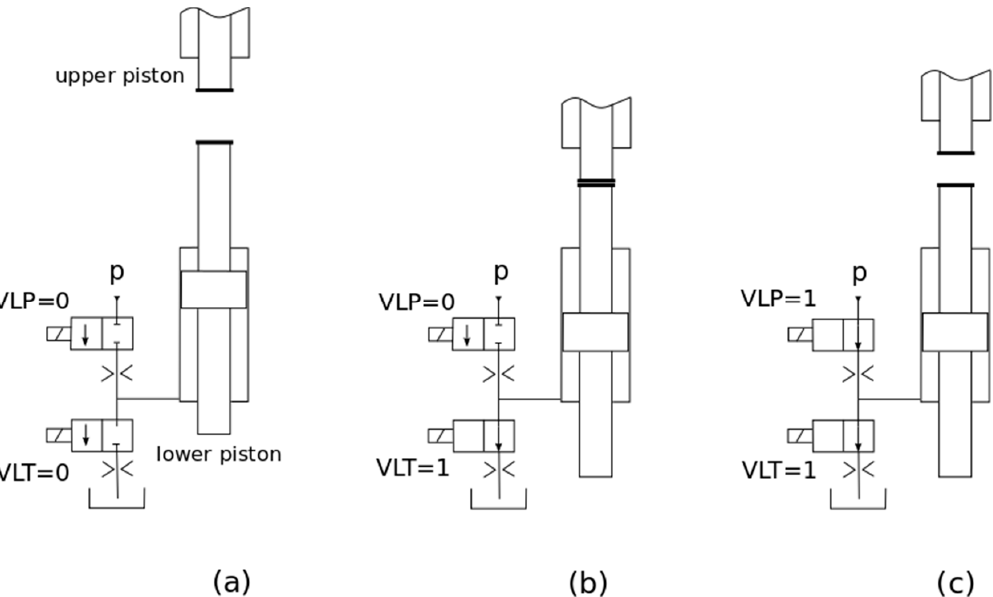
Figure 4. Different states of hydraulic circuitry that simulate a dissipative process: ( a ) the working cylinder (upper piston) moves down to contact the load simulation cylinder (lower piston); ( b ) VLT is open and oil is squeezed out through lower throttle; ( c ) the working cylinder moves back to the initial position, and the load simulation cylinder is also initialized by opening VLT and VLP.